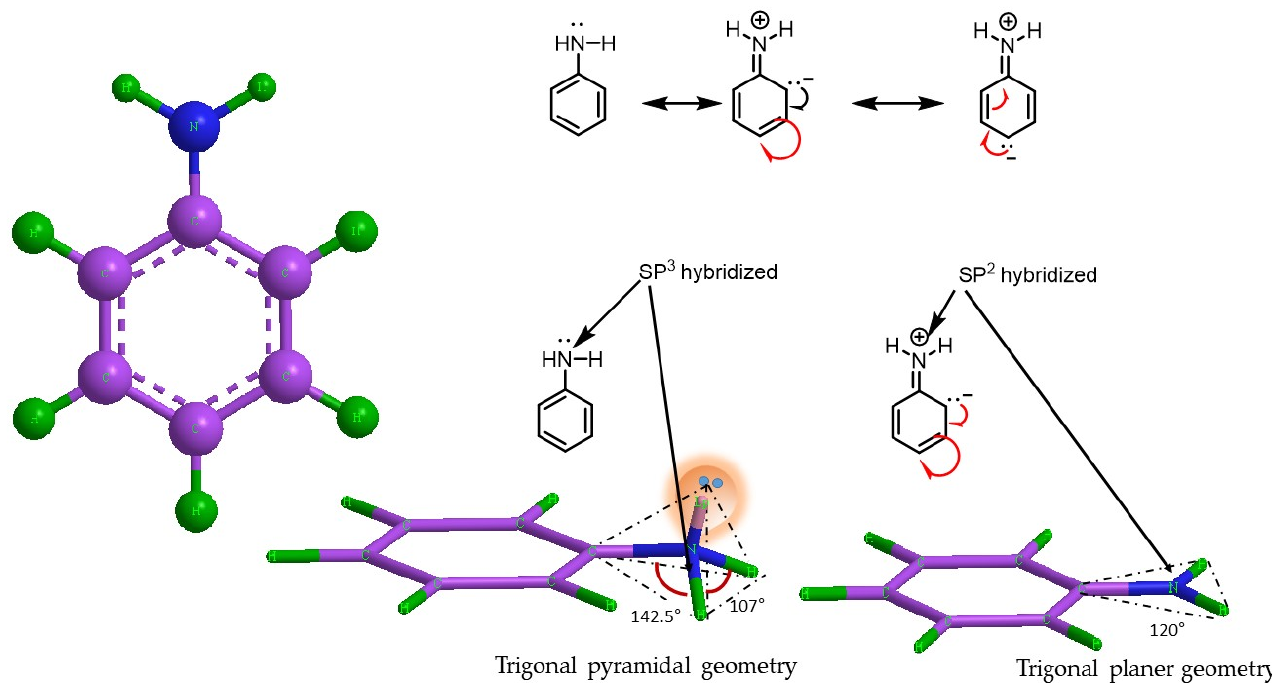
Figure 6. Chemical structure of aniline molecule and hybridization of N-atom. The lone pair of electrons present on the nitrogen atom is involved in resonance and formation of a planar geometry.